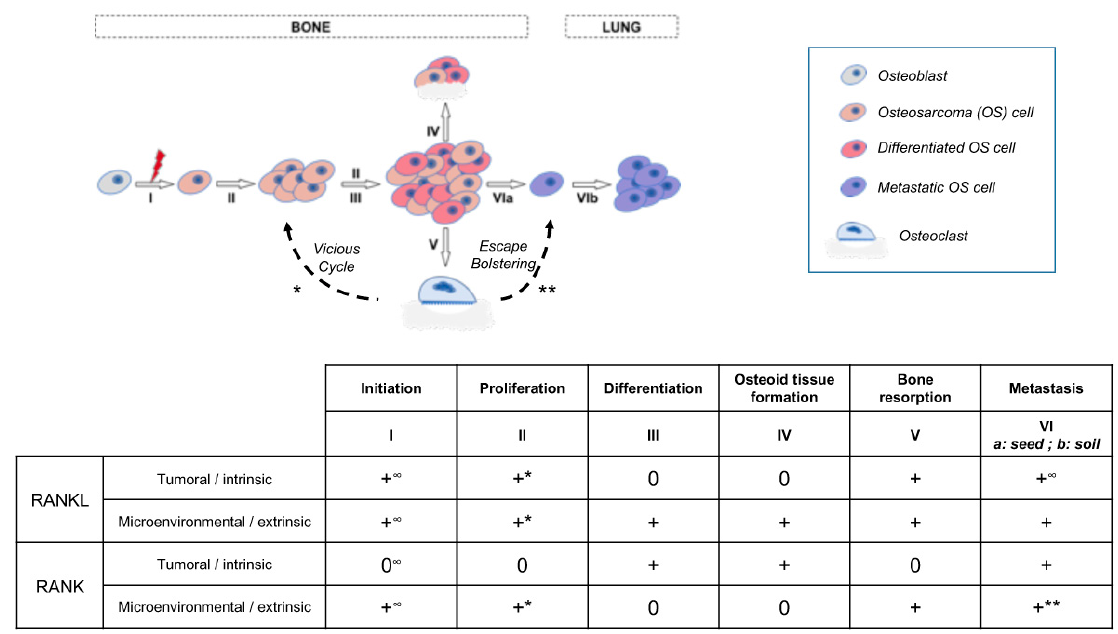
Figure 6. Schematic representation of the different stages of osteosarcoma from initiation to lung metastasis, and the implications of intrinsic and extrinsic RANKL and RANK in these different stages. +: implication revealed; 0: No implication; *: part of the vicious cycle; **: part of the escape bolstering; ∞ : according to Chen et al., 2016.